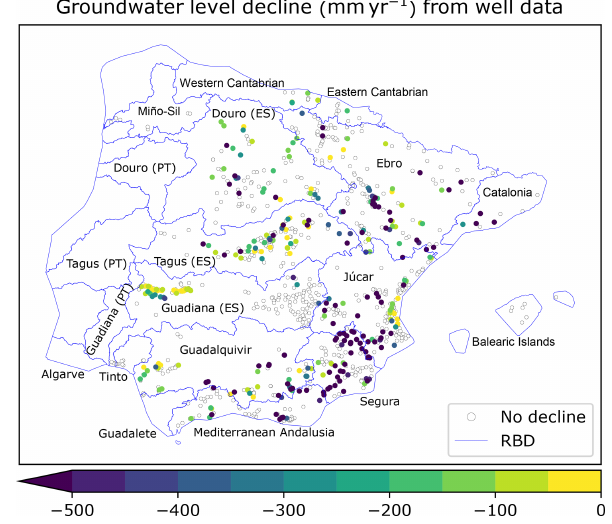
Figure 5. Groundwater depletion rates estimated from 1990–2017 reported well measurements (Government of Spain, 2020). Dis- played rates are statistically significant linear trend slopes. Iberian Peninsula RBDs are identical to WURs (Fig. 1).